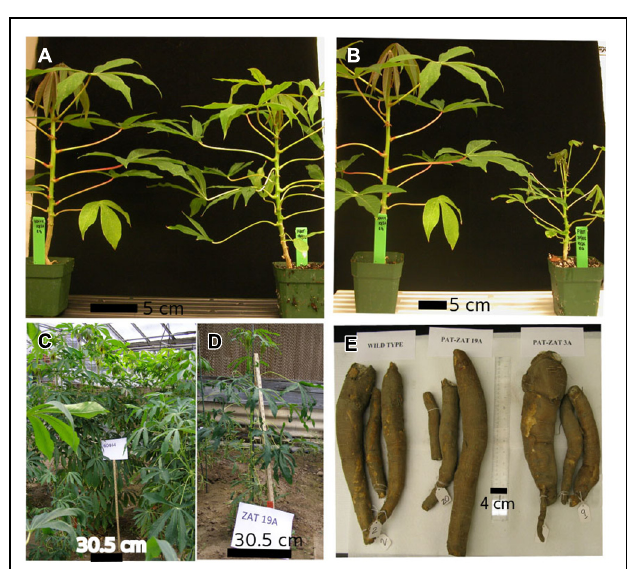
FIGURE 5 | Above ground plant phenotype in the green house (A,B), soil bed (C – Wild type, D – transgenic PAT:At MTP1 line). Starchy tubers at 12 months after planting in soil bed trials in Portageville (E)